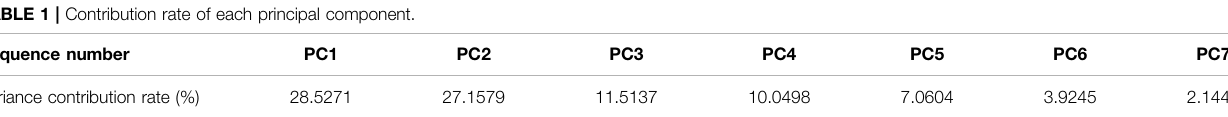
TABLE 1 | Contribution rate of each principal